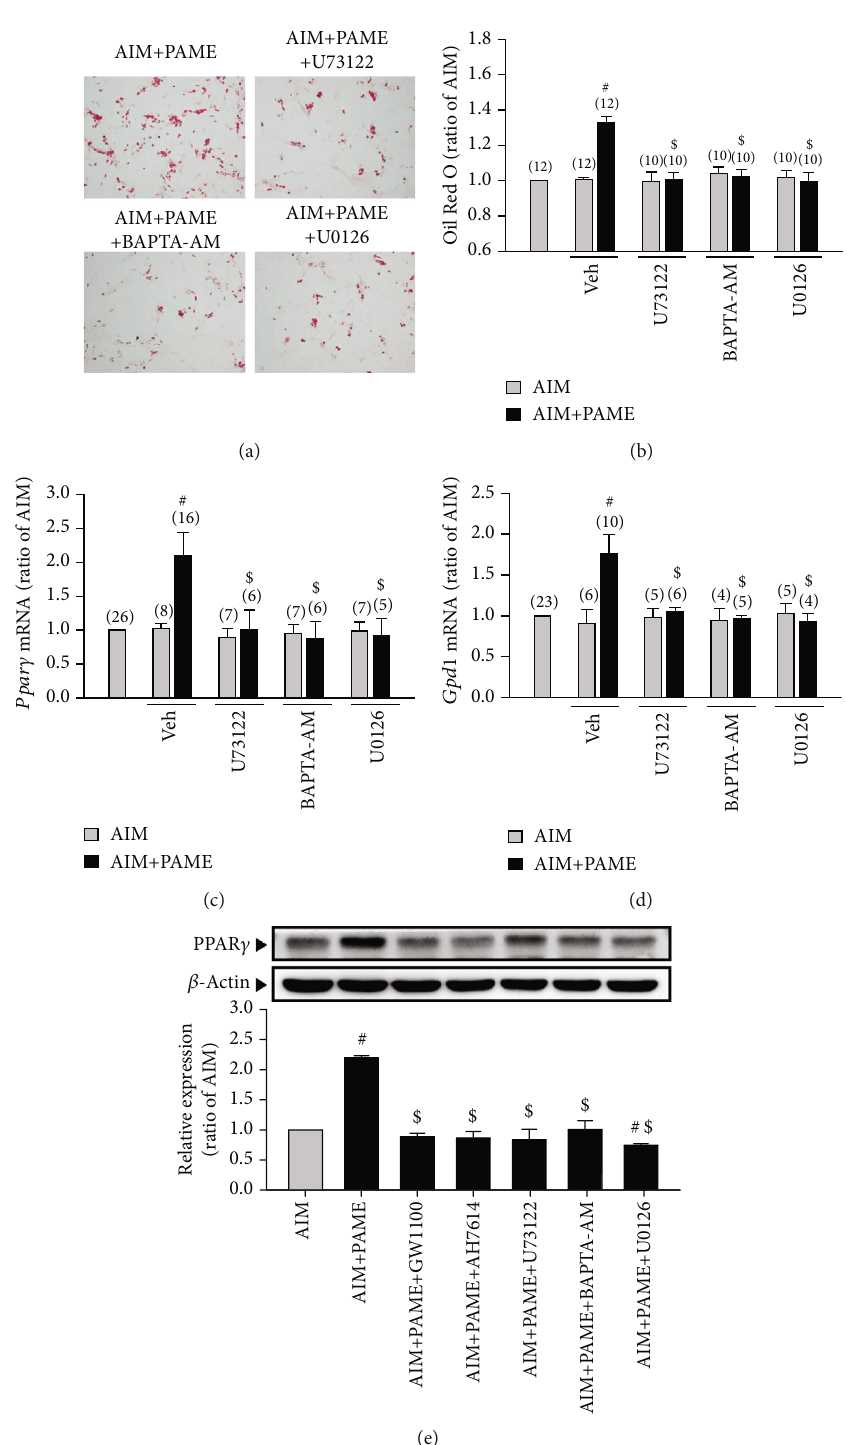
Figure 5: PAME increases adipogenic di ff erentiation through activating the GPR40/120/PLC/ERK pathway. Treatment of rAD-MSCs with PAME (50 μ M) in adipogenic induction medium for 12 days enhanced the adipogenic di ff erentiation, and these e ff ects were abolished by cotreatment with U73122, U0126, or BAPTA-AM (a, b). PAME (50 μ M) signi fi cantly increased the mRNA levels of Ppar γ (c) and Gpd1 (d) in rAD-MSCs, and these e ff ects were abolished by cotreatment with U73122, BAPTA-AM, or U0126. These antagonists were dissolved in 0.1% DMSO (vehicle). Values shown in parentheses represent the number in each group. PAME (50 μ M) increased the protein levels of PPAR γ in rAD-MSCs, and these e ff ects were abolished by cotreatment with GW1100, AH7614, U73122, BAPTA-AM, or U0126 (e) ( n = 3 ). All data represent mean ± SEM . # p < 0 : 05 , versus the AIM group; $ p < 0 : 05 , versus the AIM+PAME group. AIM: adipogenic induction medium; Veh: